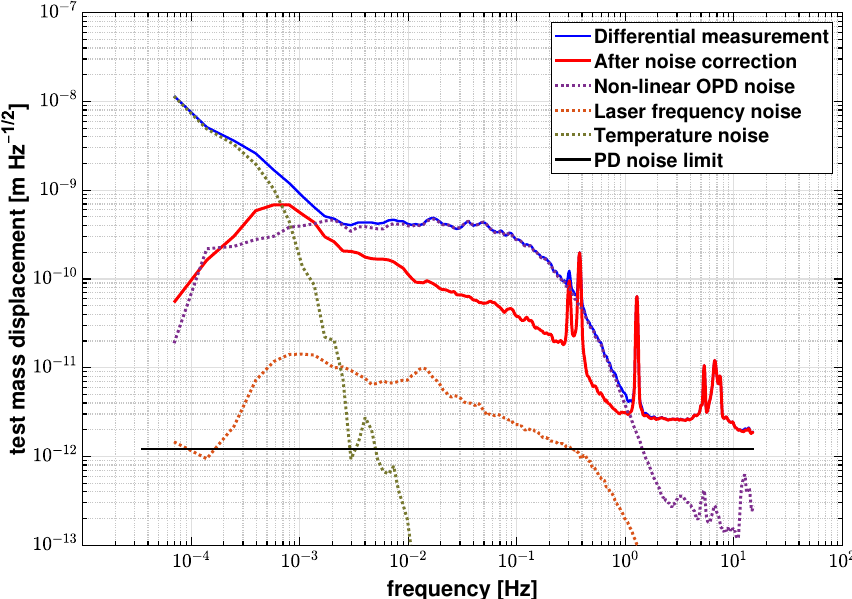
Figure 14. Overall noise correction results based on the differential measurement and con- tribution of each noise source. The residual noise floor is 3.31 × 10 − 11 m/ √ and 9.8 × 10 − 11 m/ Hz at 0.1 mHz after correction. The detection system noise level is √ 1.39 × 10 − 12 m/ Hz and also marked in this